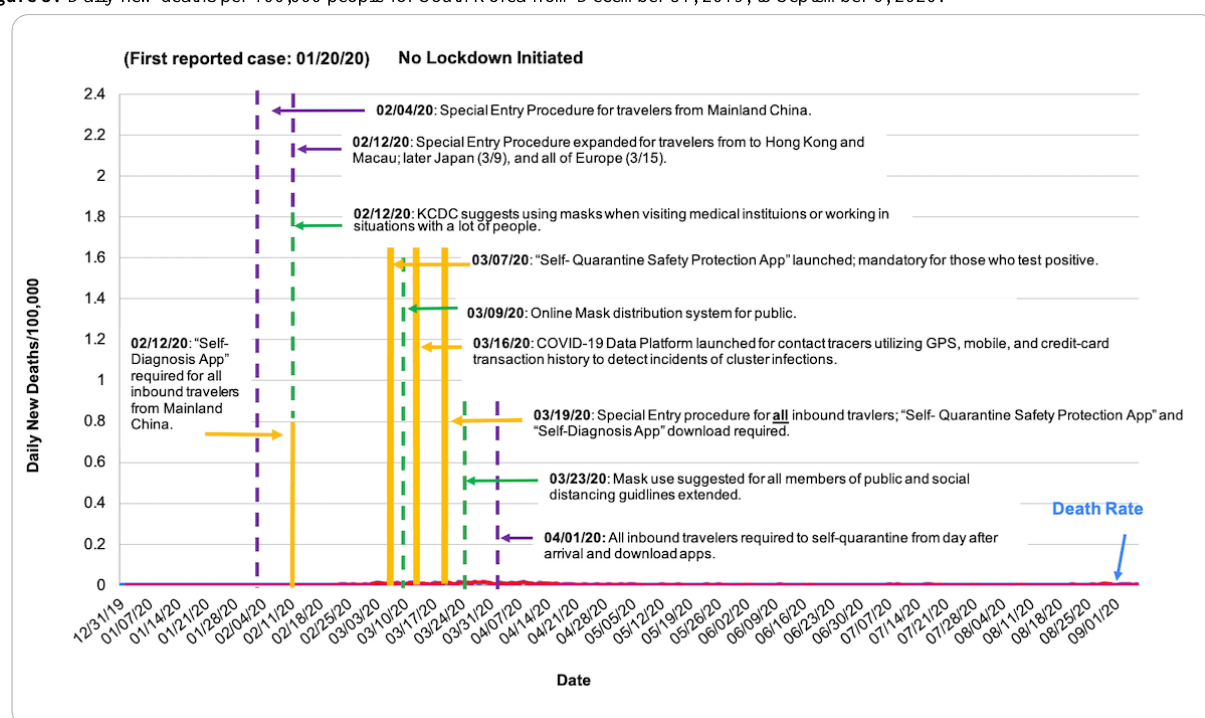
Figure 3. Daily new deaths per 100,000 people for South Korea from December 31, 2019, to September 6,